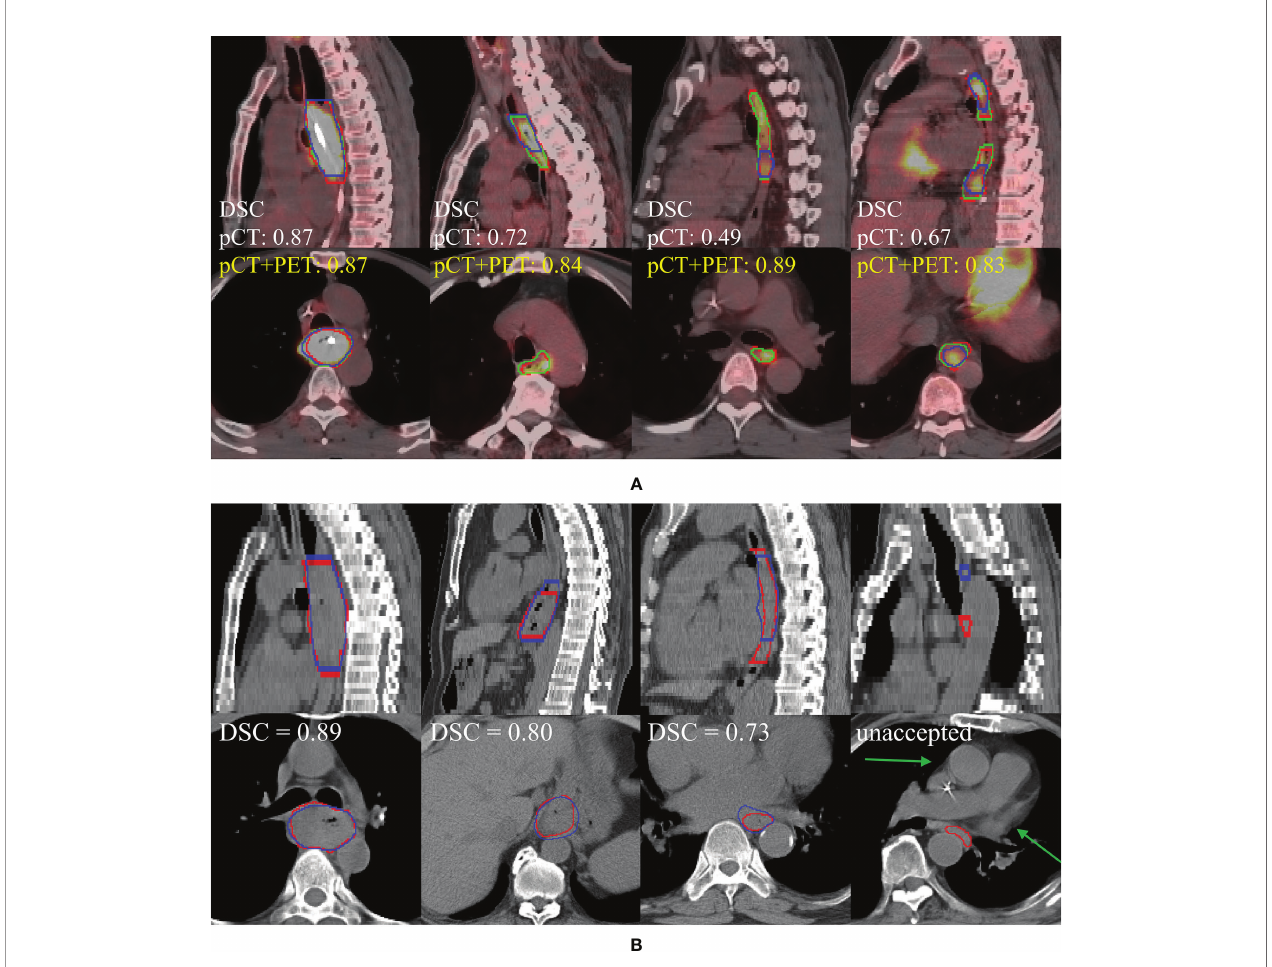
FIGURE 4 | (A) Performance comparison of pCT model and pCT+PET in the internal testing set (left to right: cT4, cT3, cT3, multifocal cT2). Red, green, and blue show the contours of ground truth reference, pCT+PET model prediction, and pCT model prediction, respectively. (B) Performance examples of pCT model in the external testing set according to the degree of manual revision (left to right): no revision, >0% – 30%, >30% – 60%, and unacceptable. Red and blue show the contours of ground truth reference and pCT model prediction, respectively. Green arrow points to the uncommon anatomy for the unacceptable case in the rightmost column. pCT, treatment planning CT; DSC, Dice similarity coef fi